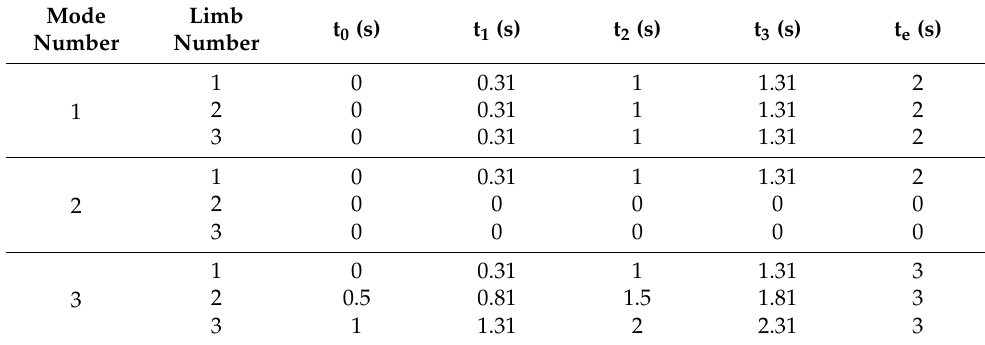
Table 3. Time data for limbs input joint motion in dynamic simulation, Figure 4.